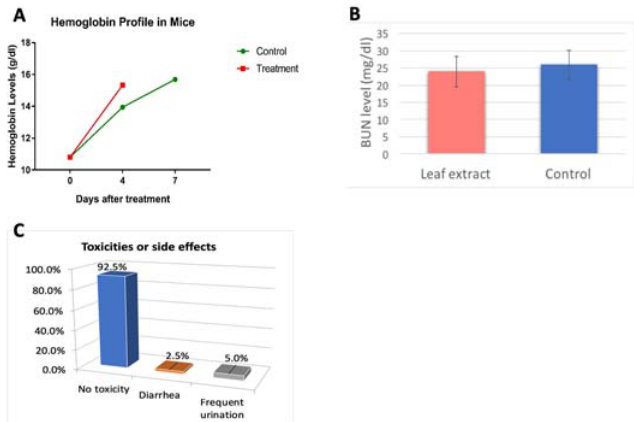
Figure 4. ( A ) Hemoglobin level comparison in mice treated with isolated plant leaf extracts versus control untreated mice; ( B ) Result of blood urea nitrogen (BUN) levels in animals administered with the isolated plant extract relative to that of animals in a control cohort. ( C ) Survey results on side effects by populations that consumed plant extract.